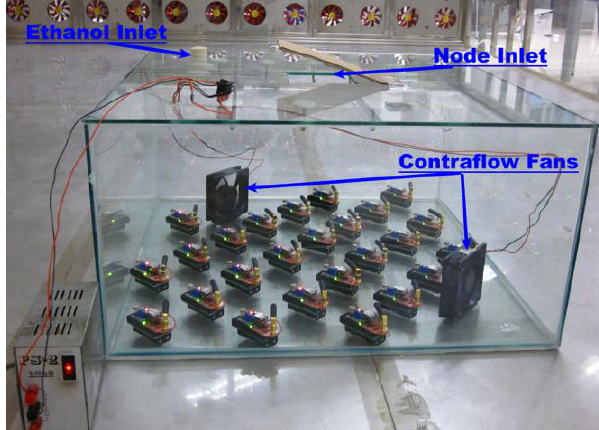
Figure 11. The experiment setup for calibrating the chemical sensors on the nodes. Different concentrations were created by dropping associated volumes of absolute ethanol into the glass box through the ethanol inlet. Both the ethanol inlet and the node inlet were sealed up during the